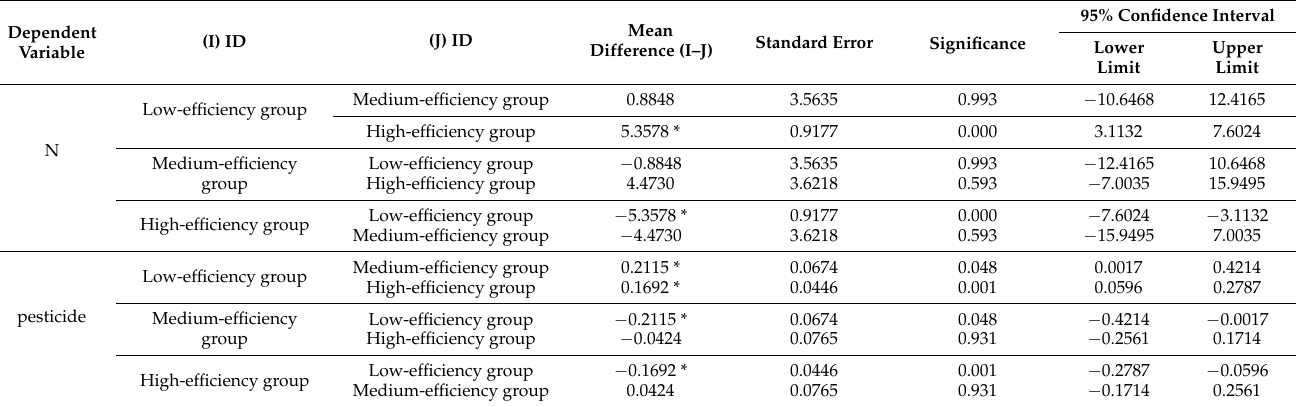
Table 8. Multiple comparison results in different rice eco-efficiency